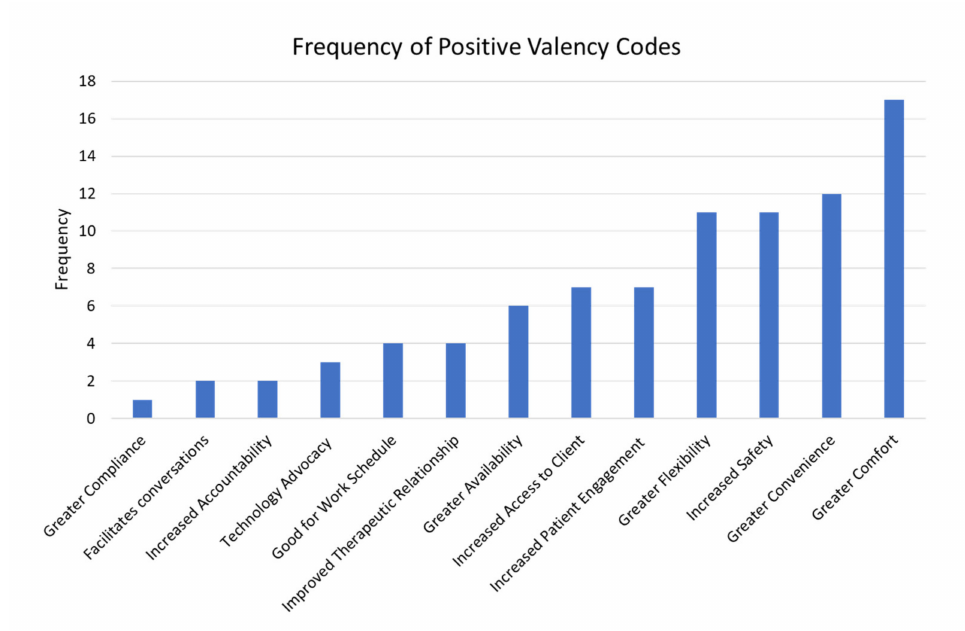
Figure 1. Frequency of positive valency codes.